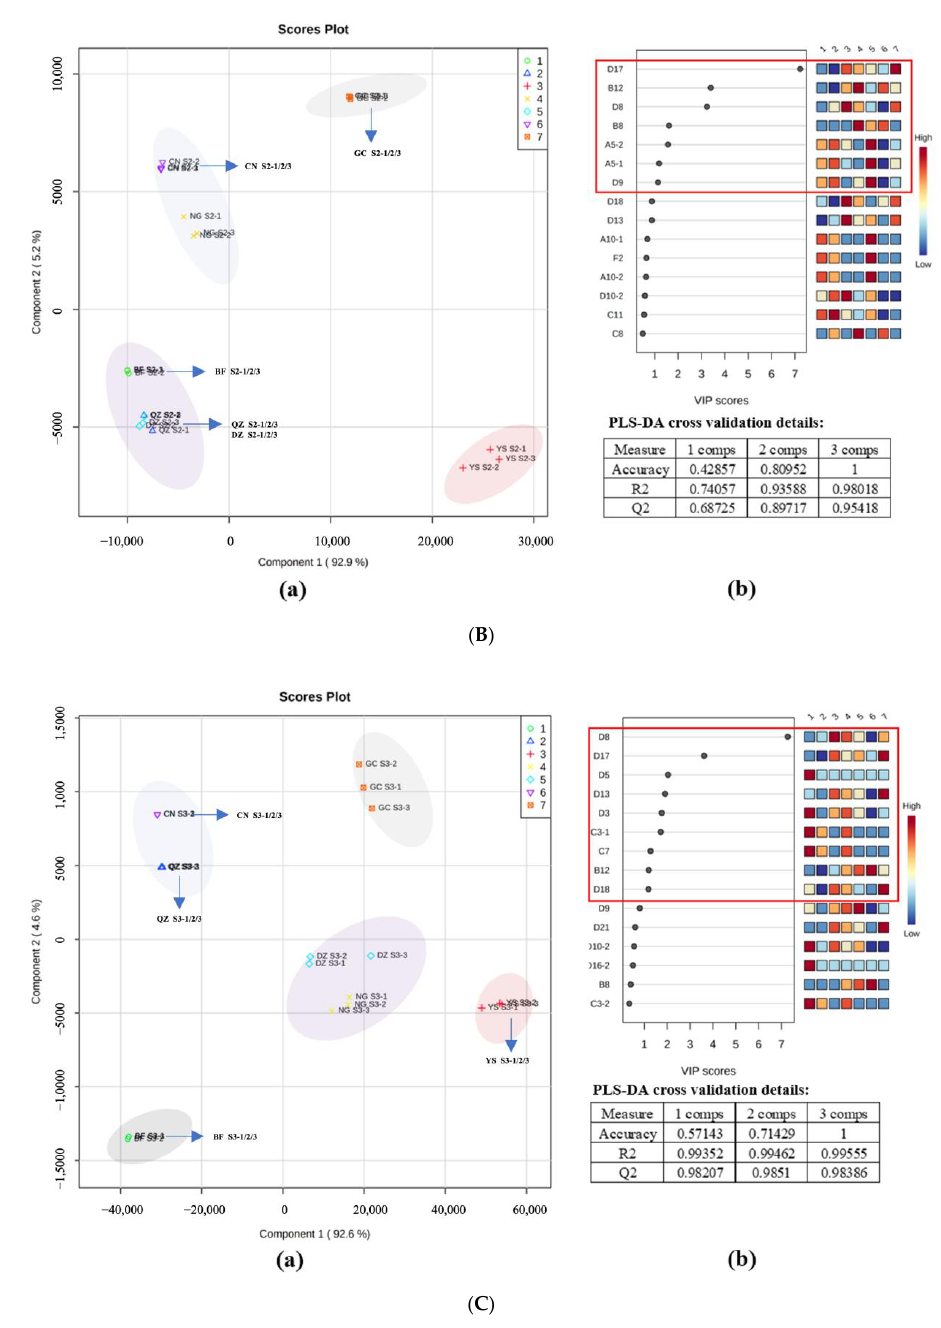
Figure 5. Partial least squares-discriminant analysis (PLS-DA) of gas chromatography–ion mobility spectrometry (GC–IMS) data. ( A ) S1 stages of green plum samples of 7 varieties; ( B ) S2 stages of green plum samples of 7 varieties; ( C ) S3 stages of green plum samples of 7 varieties. The figure includes: (a) PLS-DA score plot; (b) variable importance in projection (VIP) scores of each variable and cross-validation